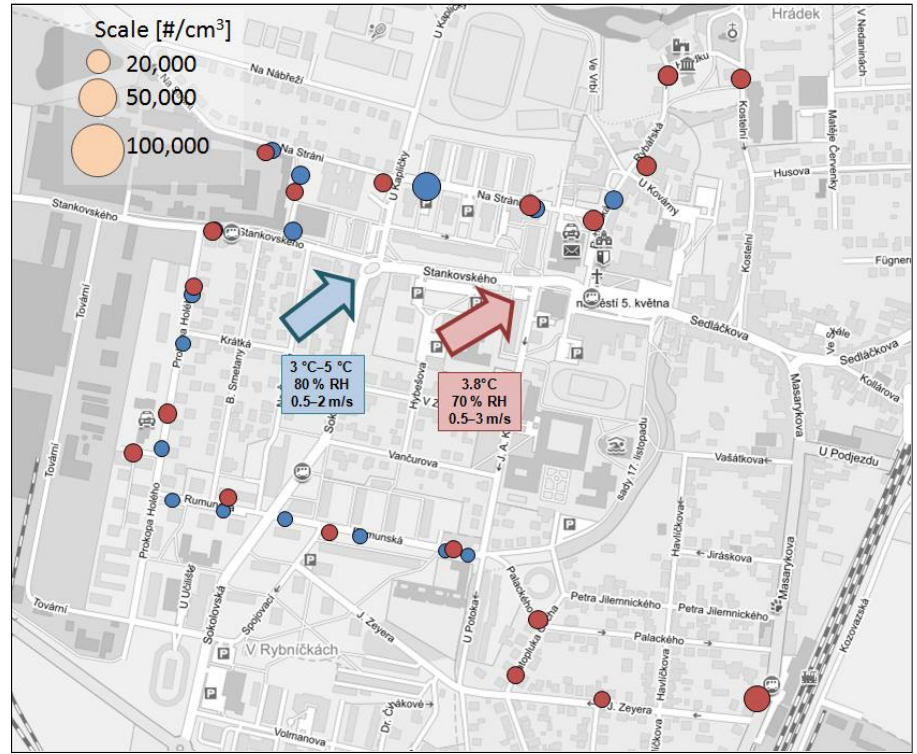
Figure 16. Particle number concentrations measured after traffic peaks on 30 January—blue, and 3 February—red; Vehicles on the main road going through the city were not proved as the main source due to very low traffic load after morning peak. Other source of UFP emissions is a motorway, about 3 km and upwind from the measurement site. Map sources: Mapy.cz, Seznam.cz